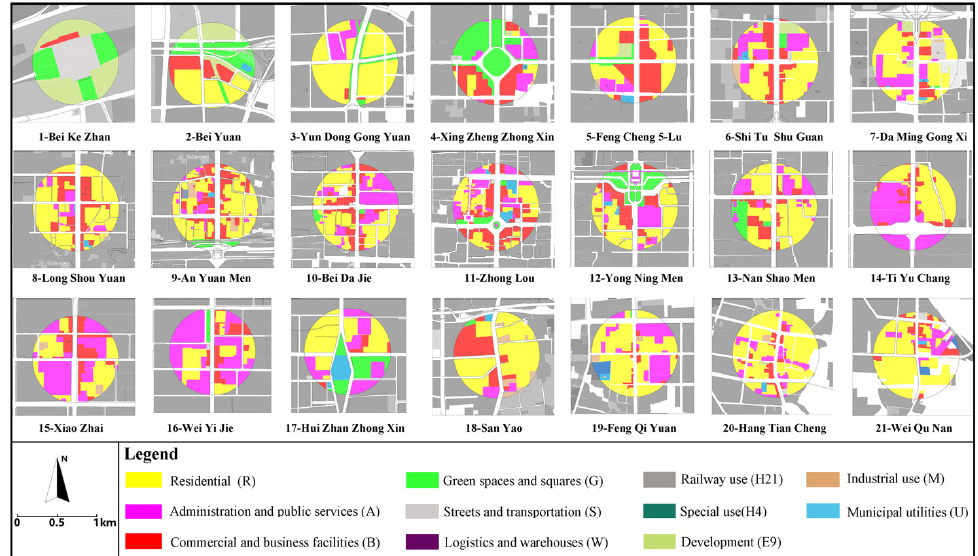
Figure 2. Processed land use data showing the scope of the research.